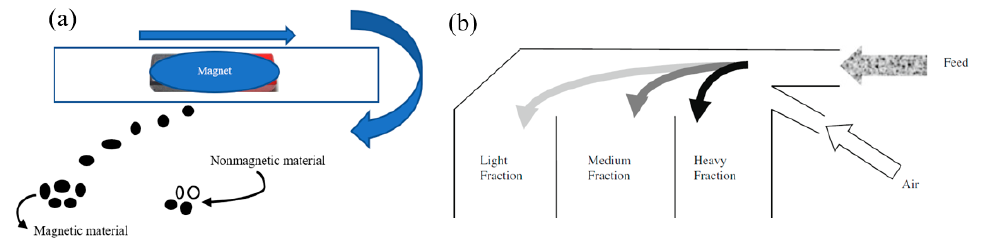
Figure 6. Techniques used for CDW pretreatments: ( a ) magnetic separation of material; ( b ) air classifier separation [71].